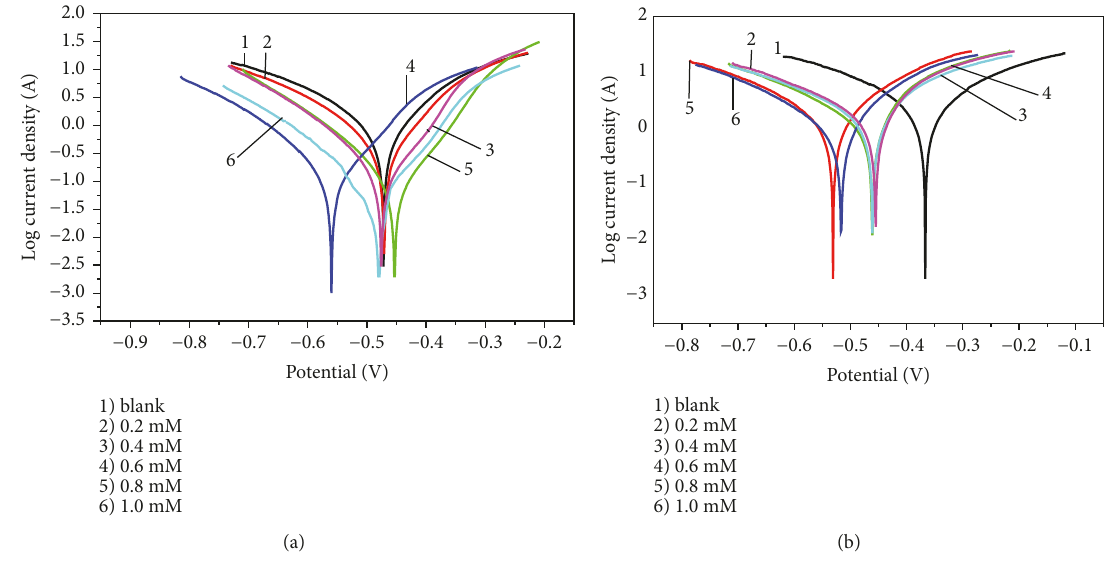
Figure 11: Tafel plots of MS coupons with and without DmChDp in (a) 1M HCl and (b) 0.5M H 2 SO 4 . Table 5: Polarization data of MS coupons with and without DmChDp in1M HCl and 0.5M H 2 SO 4